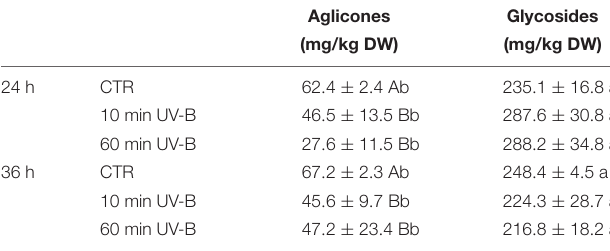
Data are mean ± SE of three biological replicates. Different letters correspond to statistically significant differences according to one-way ANOVA followed